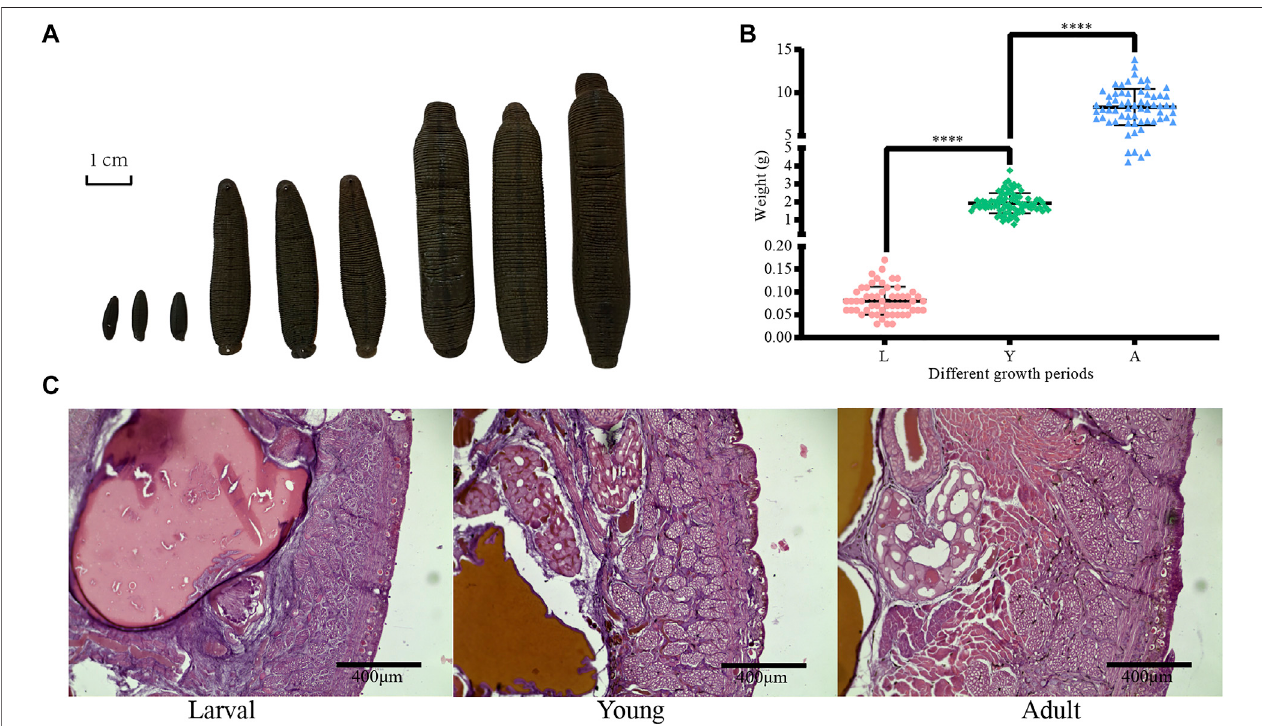
FIGURE 1 | Phenotypic data of H. manillensis . (A) Appearance of the different growth periods of H. manillensis . (B) Body weights of different growth periods of H. manillensis . (C) Transverse paraf fi n sections of the skin layers of H. manillensis at different growth